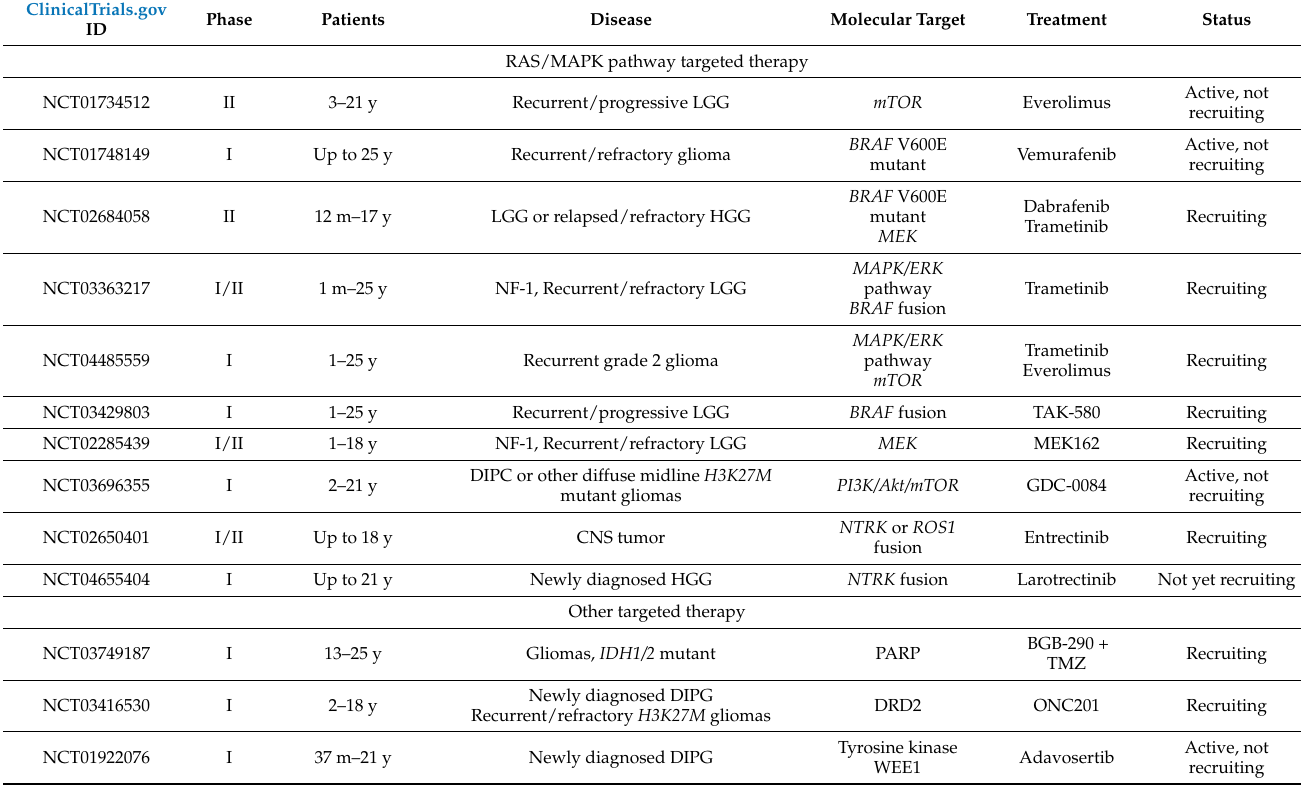
Table 2. Summary of ongoing clinical trials for targeted therapies in pediatric